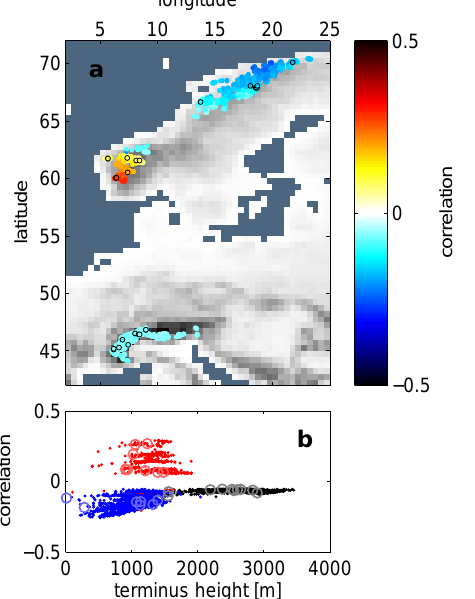
Fig. 8. Correlation between modelled monthly mass balance anomalies, i.e., MB anom , and monthly NAO index. Markers with black circle (a) and circle markers (b) indicate the results of the glaciers with more than 12 existing measurements of annual mass balance. Values below the 95% confidence interval have been omit- ted. Gray background shading: topography of the CRU TS 3.0 data. In panel (b) black is for glaciers in the Alps, red for glaciers in southern Scandinavia, blue for glaciers in northern Scandinavia.